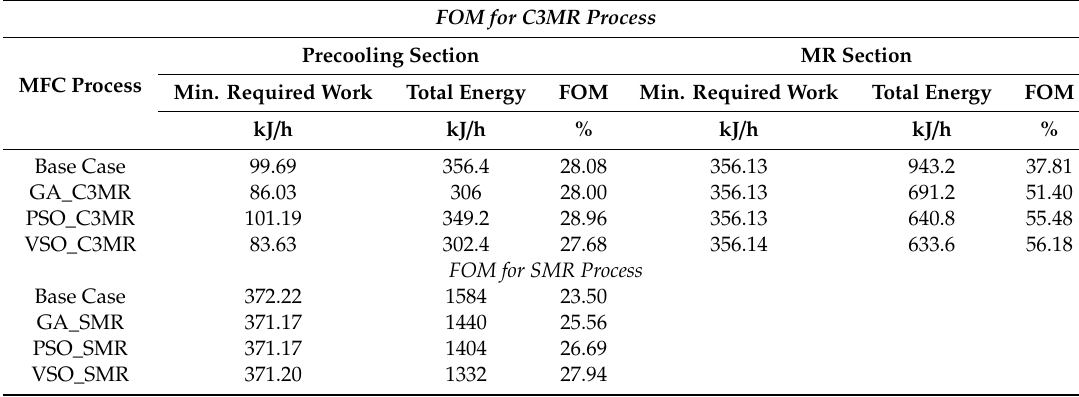
Table 9. Figure of merit (FOM) comparison analysis with base case for C3MR and SMR processes. FOM for C3MR